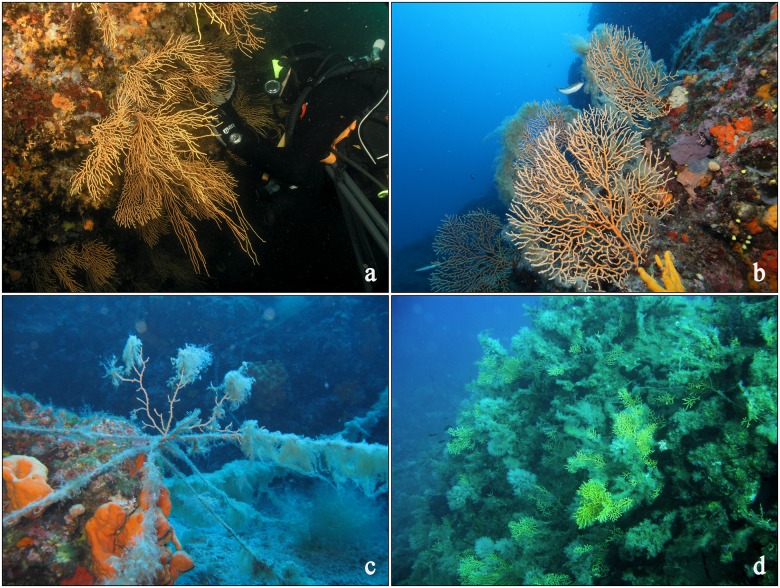
Colonies of the yellow gorgonian Eunicella cavolini exposed to different orientations and disturbances.a) in a large overhang; b) on open rock; c) under stress by fishing gear and mucilagenous algae, d) heavily overgrown during a mass mortality event. Photos a and b are courtesy of Thanos Dalianis and Panagiotis Papadelis, respectively.